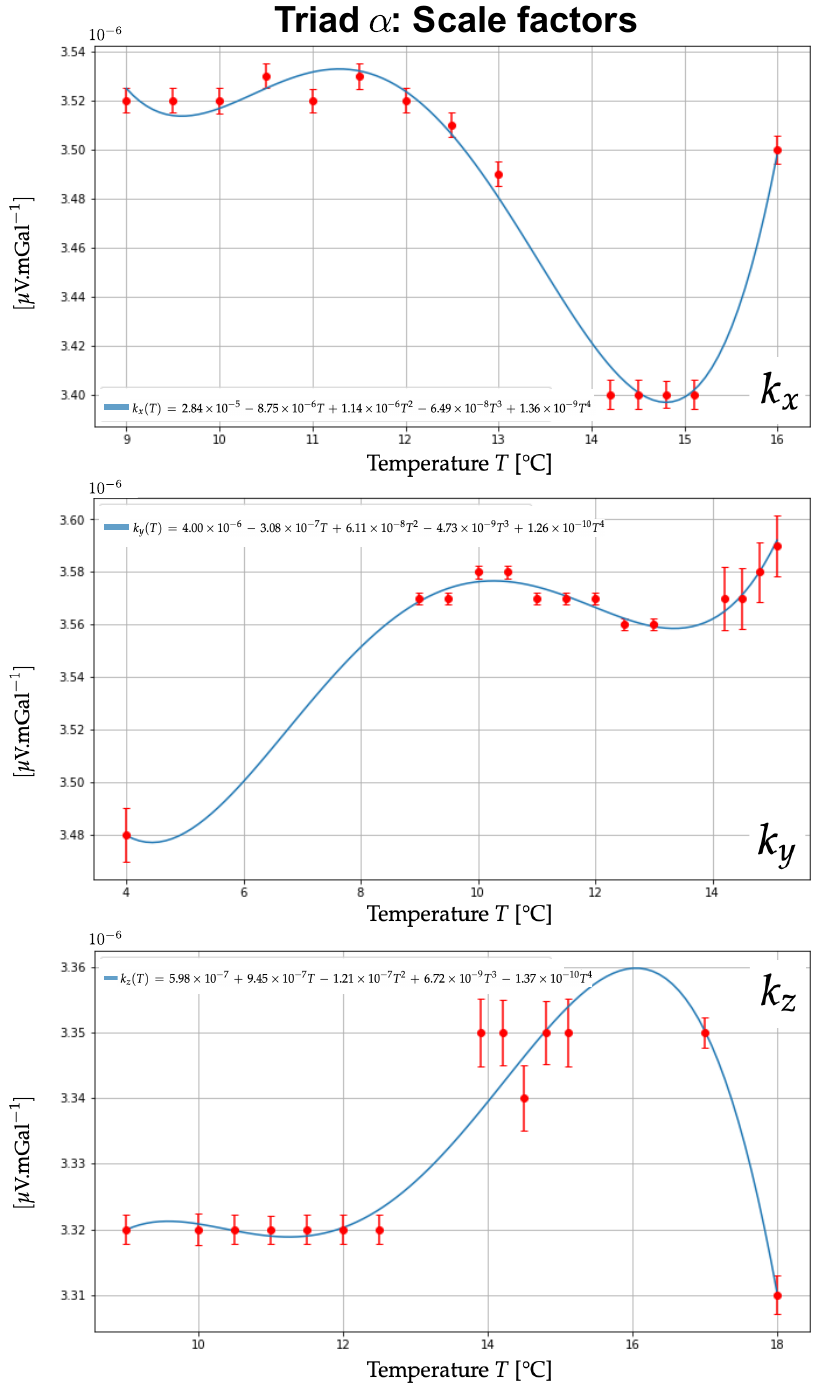
Figure 5. Graphs showing the variation of the scale factors k x ( top ), k y ( middle ) and k z ( bottom ) with temperature for the triad α . The red solid circles correspond to the values of the scale factors determined by our adjustment method and are plotted with their 1 sigma error bars. The blue curves represent the result of a polynomial fit with fourth-degree polynomials. Expressions of the polynomials are directly written out on the graphs. For all three polynomial fits, the coefficient of determination was found to be 0.987 ( k x ), 0.987 ( k y ) and 0.915 ( k z ). These coefficients did not show a significant increase for polynomial models of degrees greater than 4. The polynomial fits were validated by performing a chi-squared statistical test on the residuals with a 5% risk. This validation required the rejection of some observations that led to the failure of the chi-squared test. The same graphs are available for the triad β